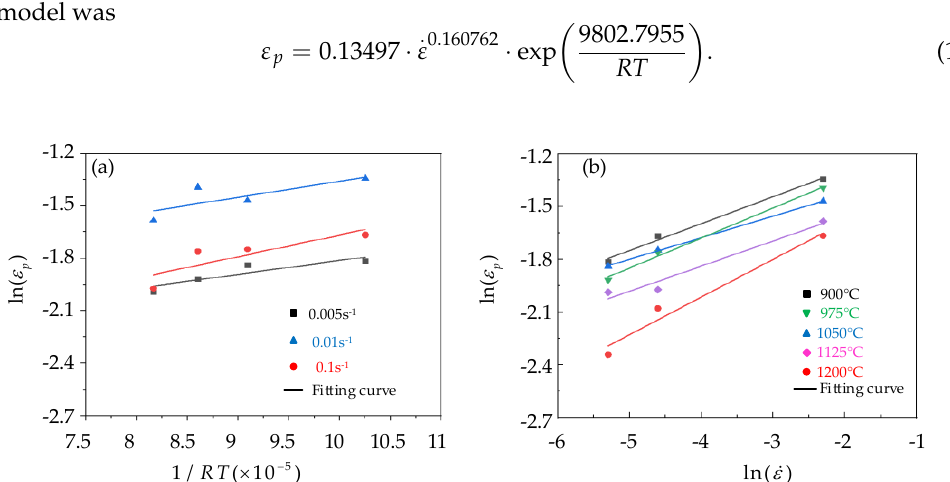
Figure 6. Determination of peak strain model parameters based on the control single variable method: ( a ) The relationship map of ln ( ε p ) − 1/ RT ; ( b ) The relationship map of ln ( ε p ) − ln p The critical strain model